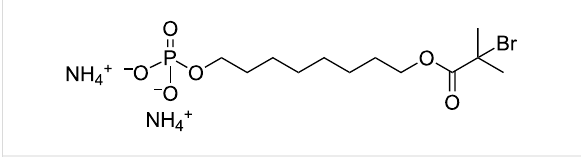
Figure 11: Chemical structure of BMPOPO 4 (NH 4 ) 2 . Reprinted with permission from W. Ma et al., Polymer 2011, 52, 5543–5550 [53]. © 2011, Elsevier